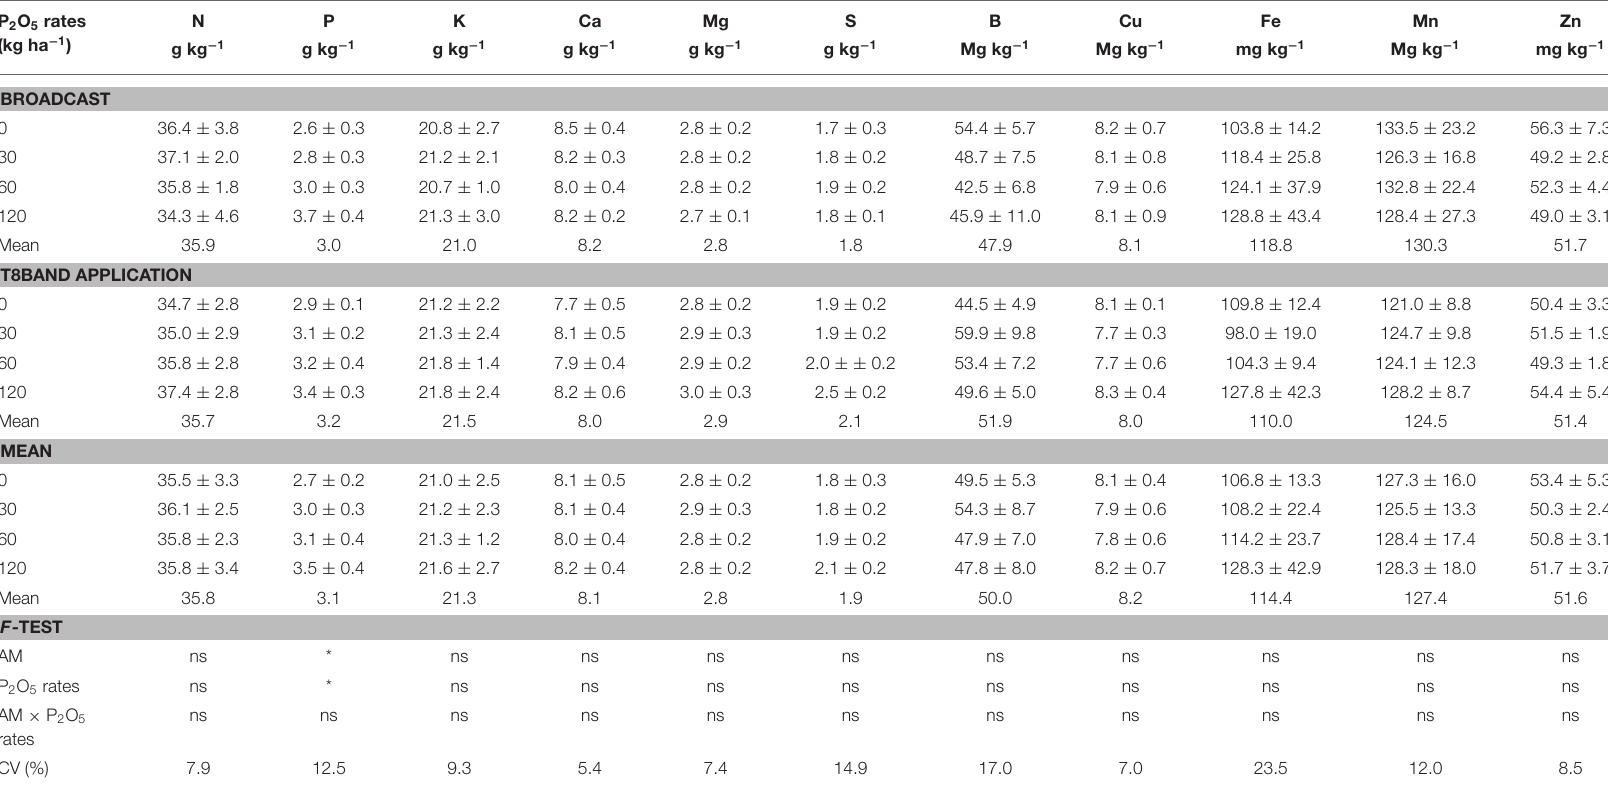
TABLE 3 | Leaf N, P, K, Ca, Mg, S, B, Cu, Fe, Mn, and Zn concentrations as influenced by P 2 O 5 rates, with two application methods (AM) (broadcast or band application), on the average of two growing seasons of soybean crops, Londrina, Paraná State,